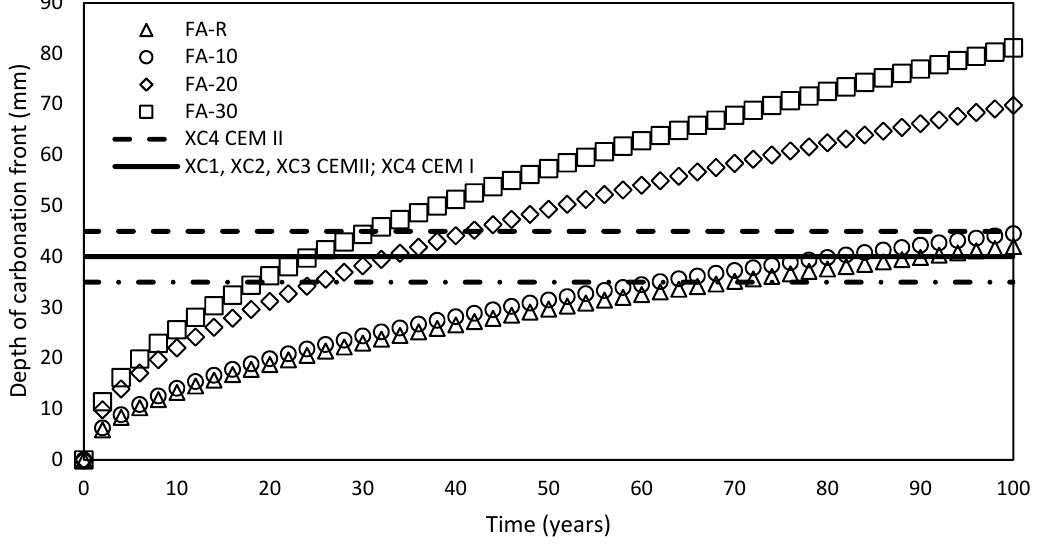
Figure 15. Calculated values of the durability index for single mixtures.